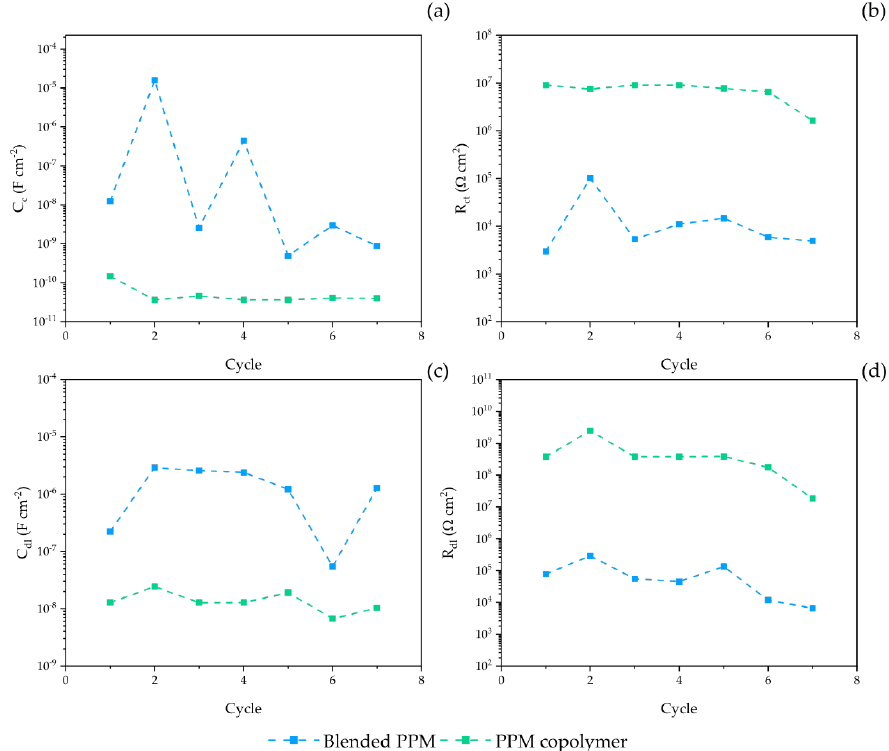
Figure 7. Evolution of the coating capacitance C c ( a ), pore resistance (R c ), polarization resistance (R dl ) and double layer capacitance (C dl ) during the ACET test of a 30 μm PPM copolymer coating (green) and a 30 μm coating of blended PPM (blue). Dotted lines represent a guide for eye only.